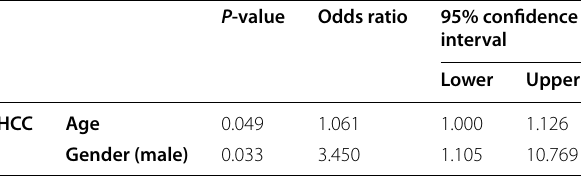
Table 6 Multivariate logistic regression to detect independent predictors of de novo